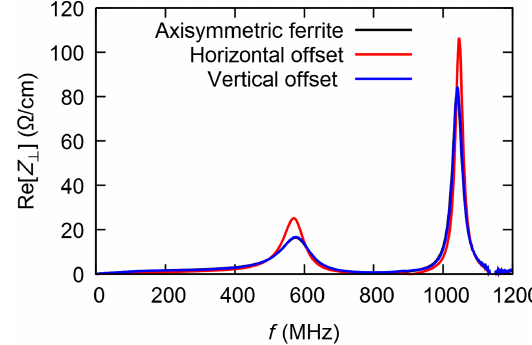
FIG. 9. Simulation geometry of shorted pillbox gap with the addition of a ferrite (shown in red). Left: cross section of gap geometry at x ¼ 0 ( θ ¼ π = 2 ). Cross sections at z ¼ 3 cm of (top right) axisymmetric ferrite ring. Bottom right: discrete ferrite arc.